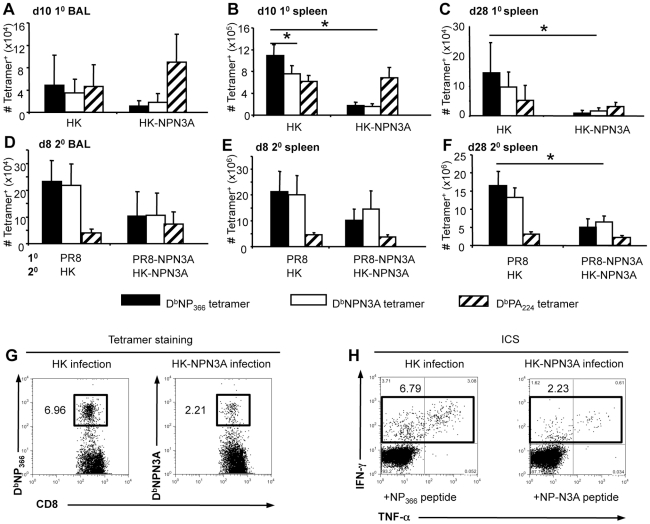
Acute and recall CD8+ T cell responses to DbN3A and DbNP366.The magnitude of CD8+ T cell responses at the peak (d10 1o A,B; d8 2o D,E) or memory (d28, CF) phases following 1o (A–C) or 2o (D–F) infection. Cells were stained with the DbNP366-PE, DbNPN3A-PE or DbPA224-PE tetramers and anti-CD8-PerCPCy5.5 mAb. The numbers of epitope specific CD8+ T cells were calculated from the % cells staining and the total cell counts. The wt HK or HK-NPN3A viruses were used for 1o i.n. infection and 2o i.n. challenge of i.p.-primed (PR8 or PR8-NPN3A i.p. >30d previously) B6 mice. Data are mean±SD n = 5 mice per group, * = p<0.01. Memory T cell numbers were also analysed on d60, and the tetramer analysis was replicated using the ICS assay (data not shown). (G, H) Representative dot plots are shown for (G) DbNP366 or NPN3A tetramer staining and (H) intracellular cytokine assay after infection with either HK or HK-NPN3A for the same individual mouse.